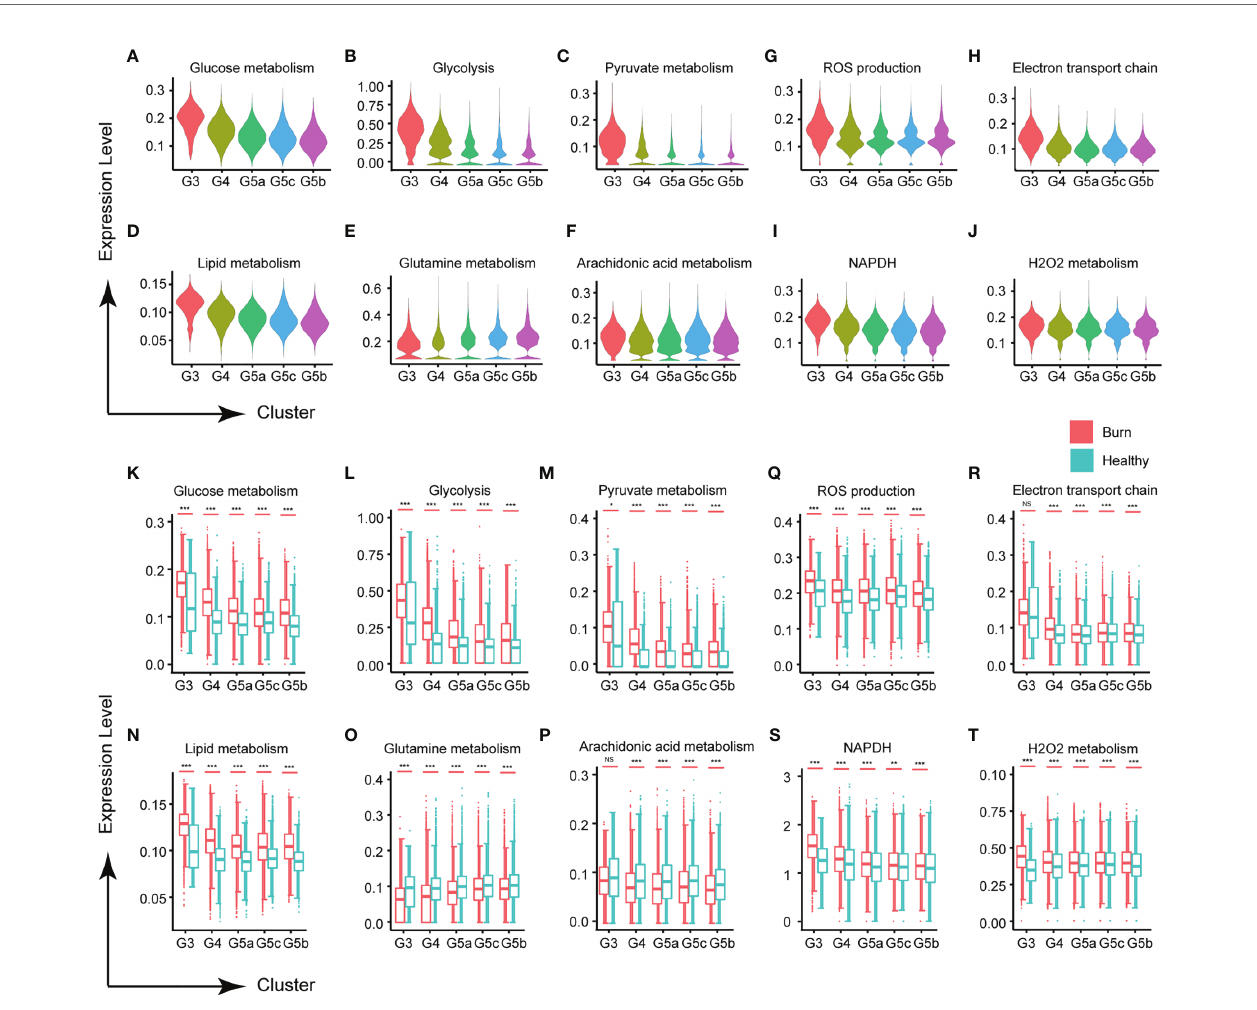
FIGURE 5 | Changes in neutrophil metabolism in early stages of severe burn injuries. (A – C) Changes in glycometabolism-related functions in each subgroup. Glucose metabolism (A) , glycolysis (B) and pyruvate metabolism (C) . (D – F) Scores of lipid metabolism related functions of each subgroup. Lipid metabolism (D) , glutamine (E) and arachidonic acid metabolism (F) . (G – I) Changes in ROS metabolism-related functions in each subgroup. ROS production (G) , electron transport chain (H) , NADPH (I) and H 2 O 2 metabolism (J) . (K – T) Changes in functions associated with glucose metabolism, lipid metabolism and ROS metabolism under healthy and burned conditions. *p < 0.05, **p < 0.01, ***p < 0.001, ns, not